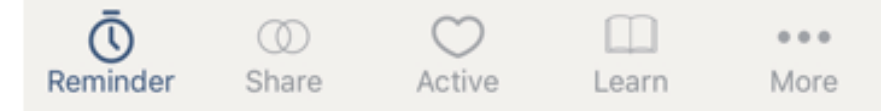
Figure 1. Main navigation panel within the app.